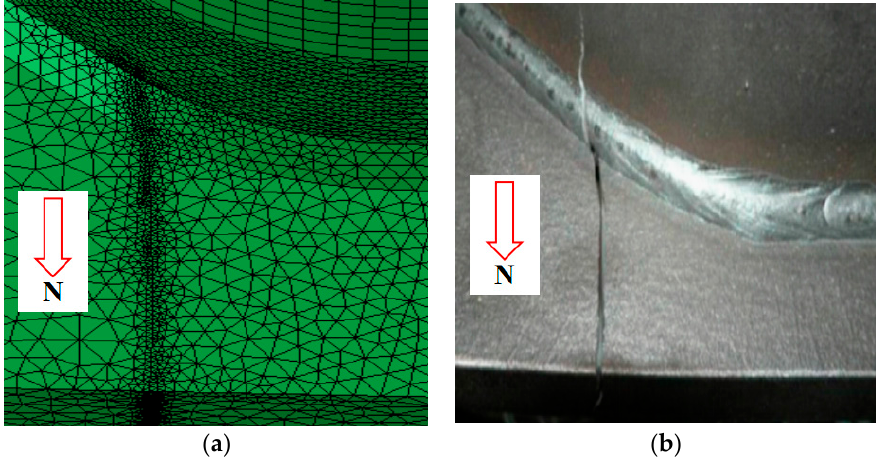
Figure 9. ( a ) Simulation result under the K equ +SERR ( b ) and test result in previous paper, reproduced from [38], with permission of Elsevier 2014.